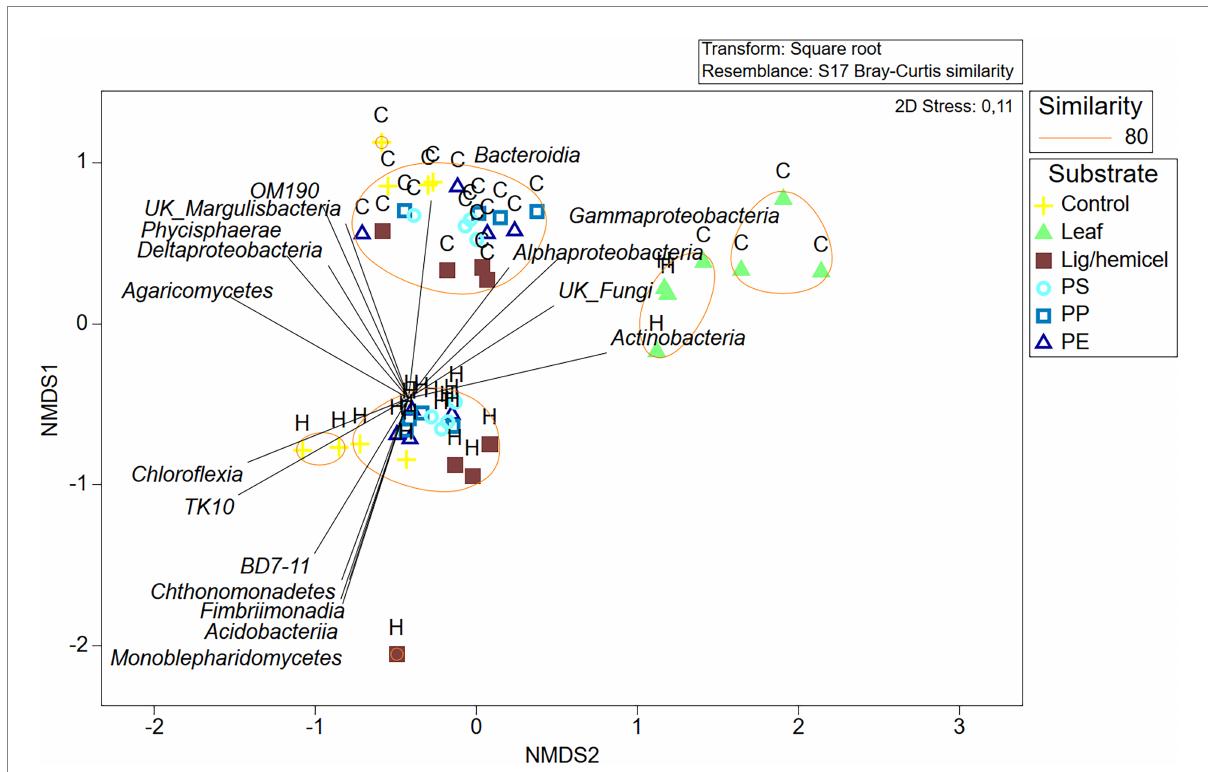
FIGURE 6 Non-metric multidimensional scaling plot of Bray–Curtis similarity of standardized and square root transformed OTU data at the class level. Letter H indicates humic lake water and letter C indicates clear lake